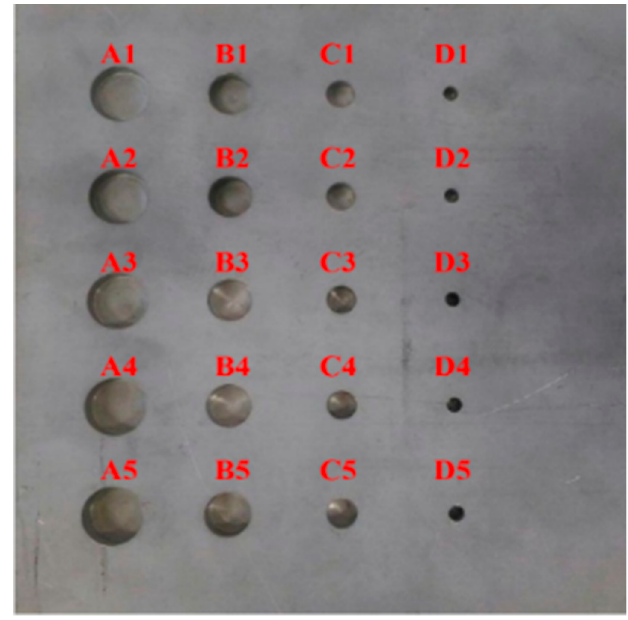
Figure 5. Aluminum sample with simulated defects used for tests.